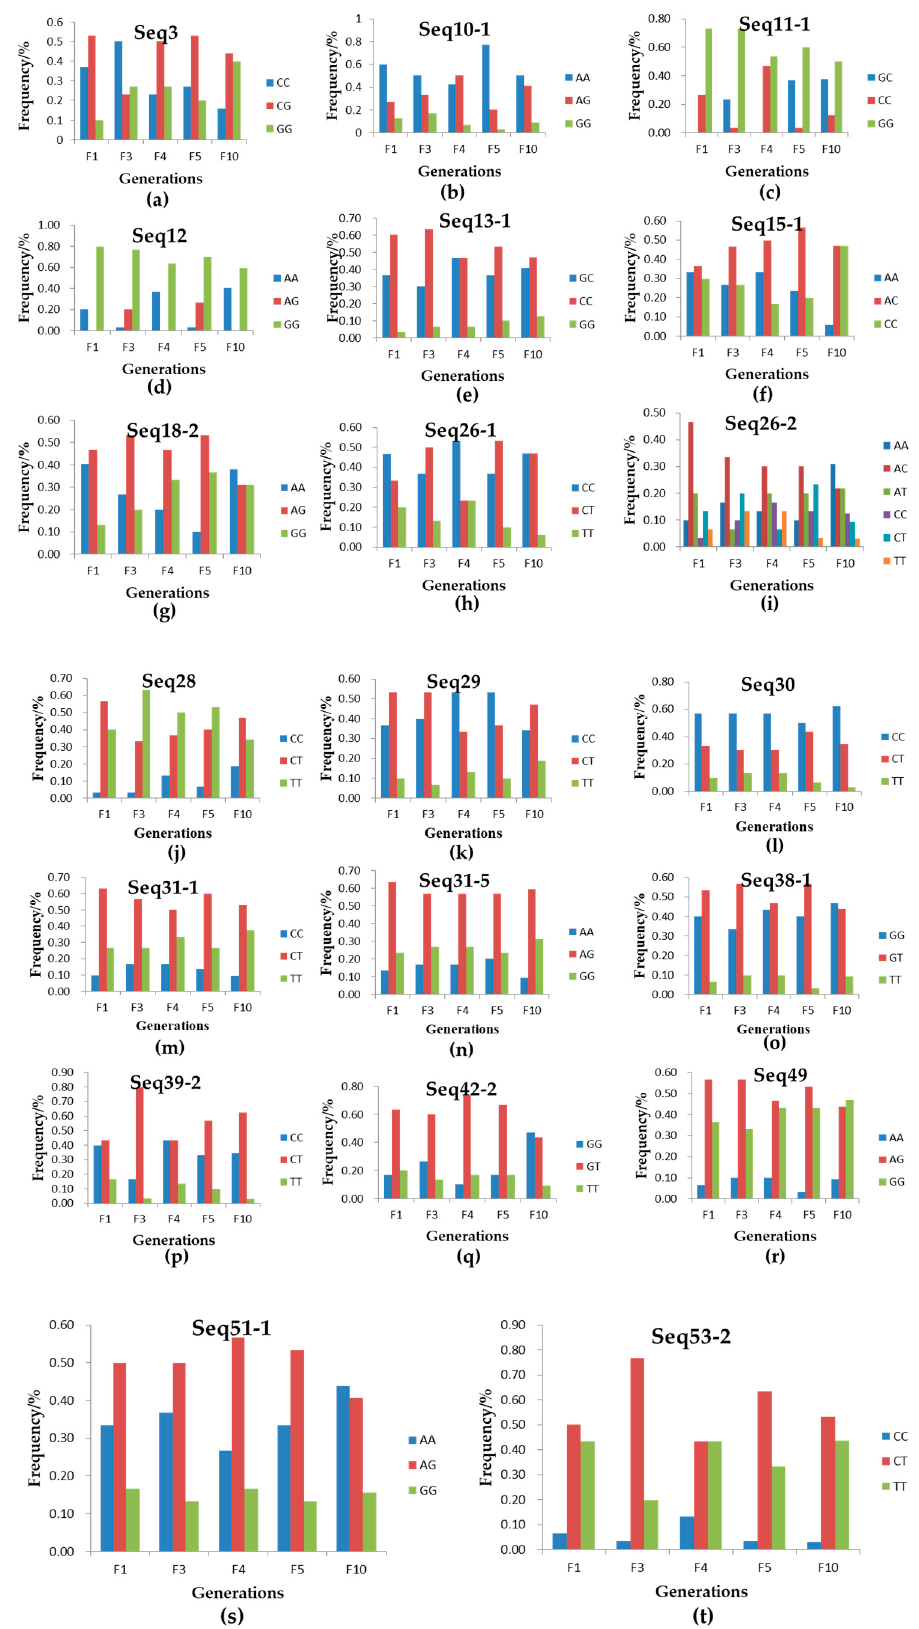
Figure 1. Genotype frequency distributions of 20 SNPs loci in the five closed colonies. ( a )–( t ) Individual SNP genotype frequencies among the five generations.